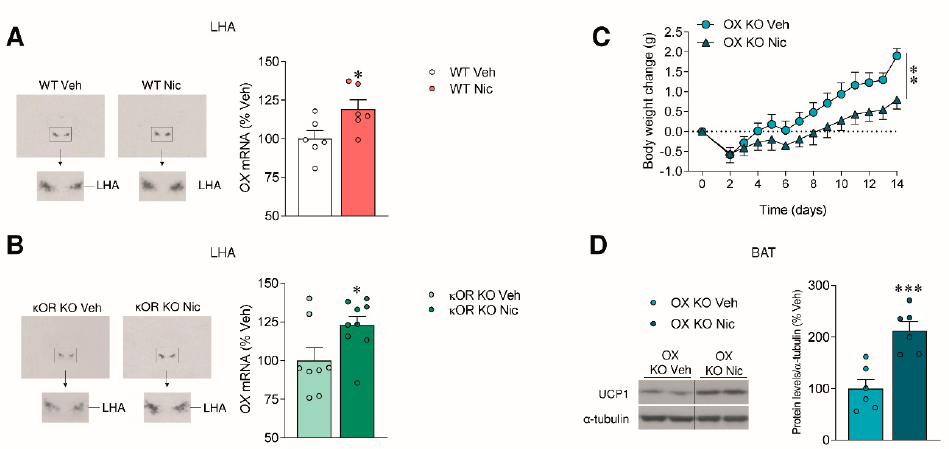
Figure 2. Nicotine’s effect on orexin in the lateral hypothalamic area (LHA). ( A , B ) OX mRNA levels in the LHA ( n = 6–9 mice/group) in WT ( A ), and κ OR KO ( B ), mice treated SC with vehicle or nicotine through osmotic minipumps for 14 days. ( C ) Body weight change ( n = 6 mice/group), ( D ) protein levels of UCP1 in the BAT ( n = 6 mice/group) of OX KO mice treated SC with vehicle or nicotine through osmotic minipumps for 14 days. * p < 0.05, ** p < 0.01 vs. *** p < 0.001 vehicle. Data are expressed as mean ± SEM. The bands in gels from panel D have been spliced from the same original gels.